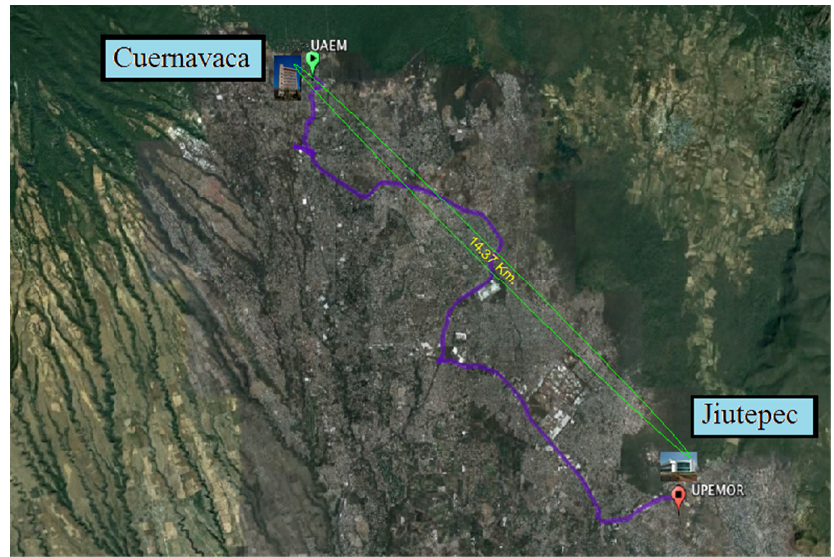
Figure 3. Location of MiniGrid in the Mexican state of Morelos.